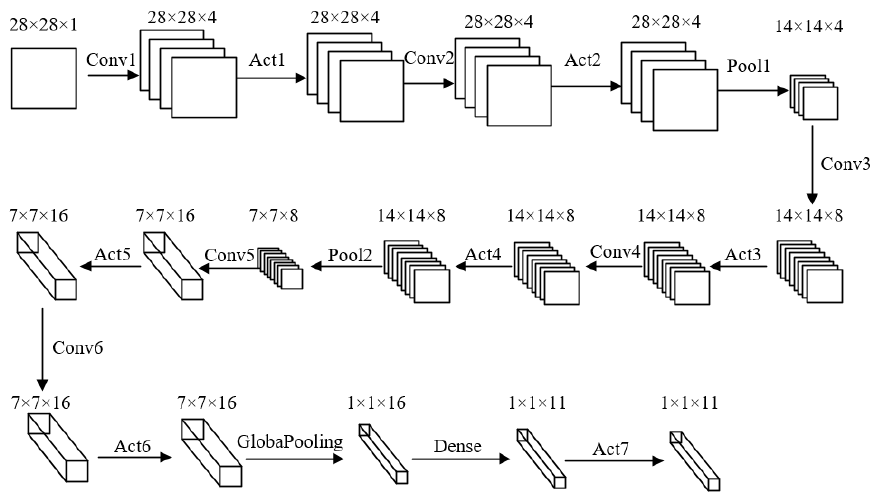
Figure 1. Convolutional neural network model.